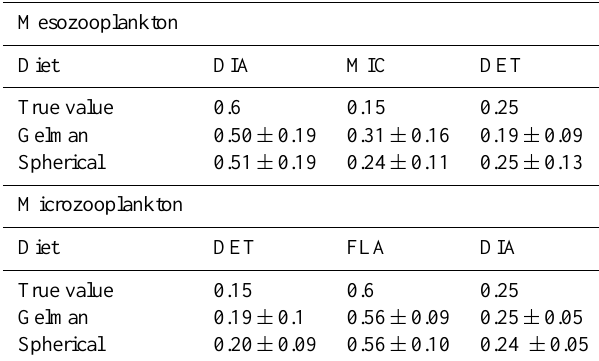
Table 1. Zooplankton grazing preferences (π i ) i = 1 : 3 : mean and standard deviation (computed over the 20 experiments) of the means of preferences obtained at the final time.